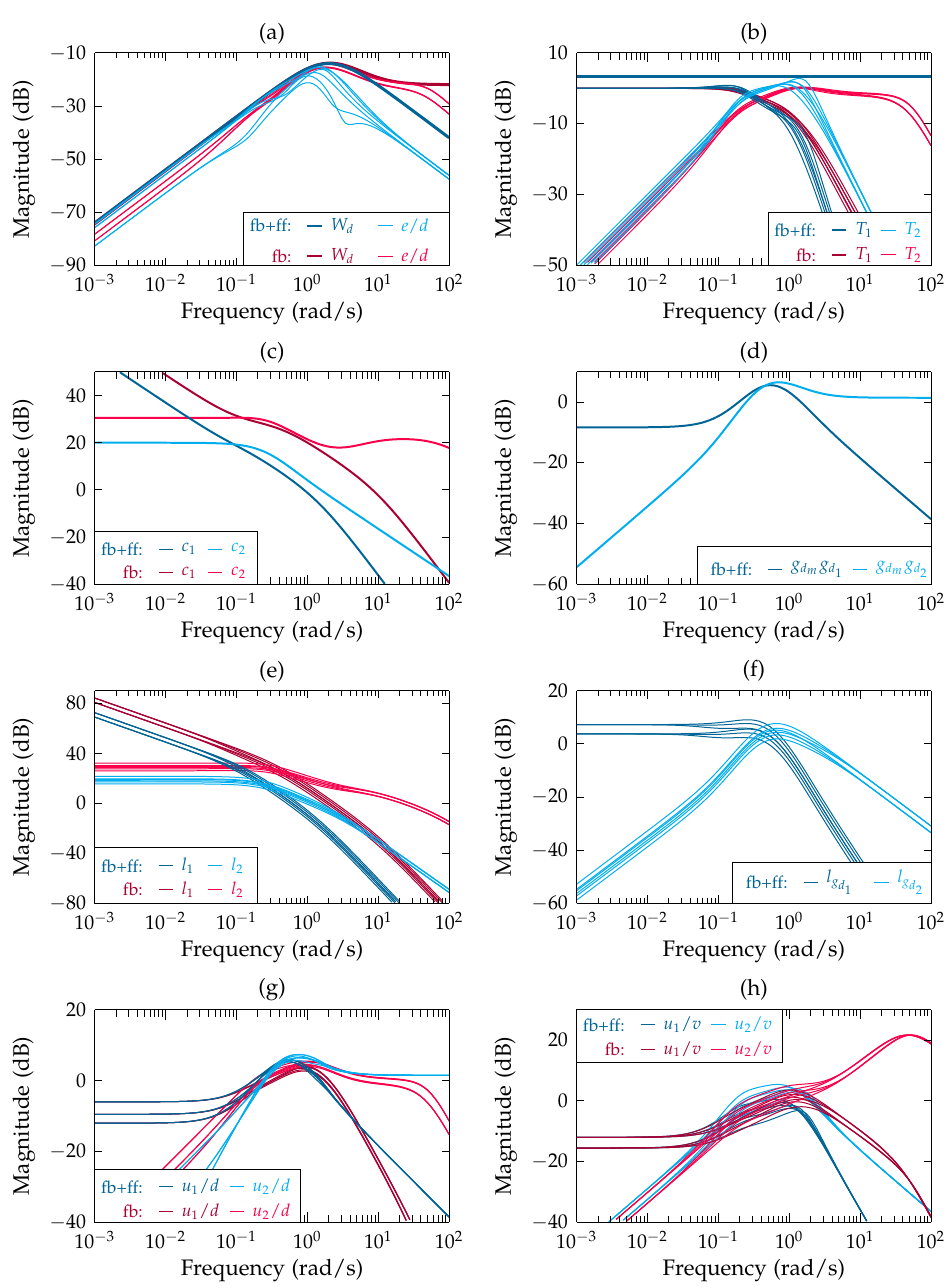
Figure 5. Magnitude frequency responses: ( a ) Output error, ( b ) stability, ( c ) feedback controllers, ( d ) feedforward elements, ( e ) feedback open-loops, ( f ) feedforward open-loops, ( g ) control inputs for disturbance rejection, ( h ) sensor noise at the control